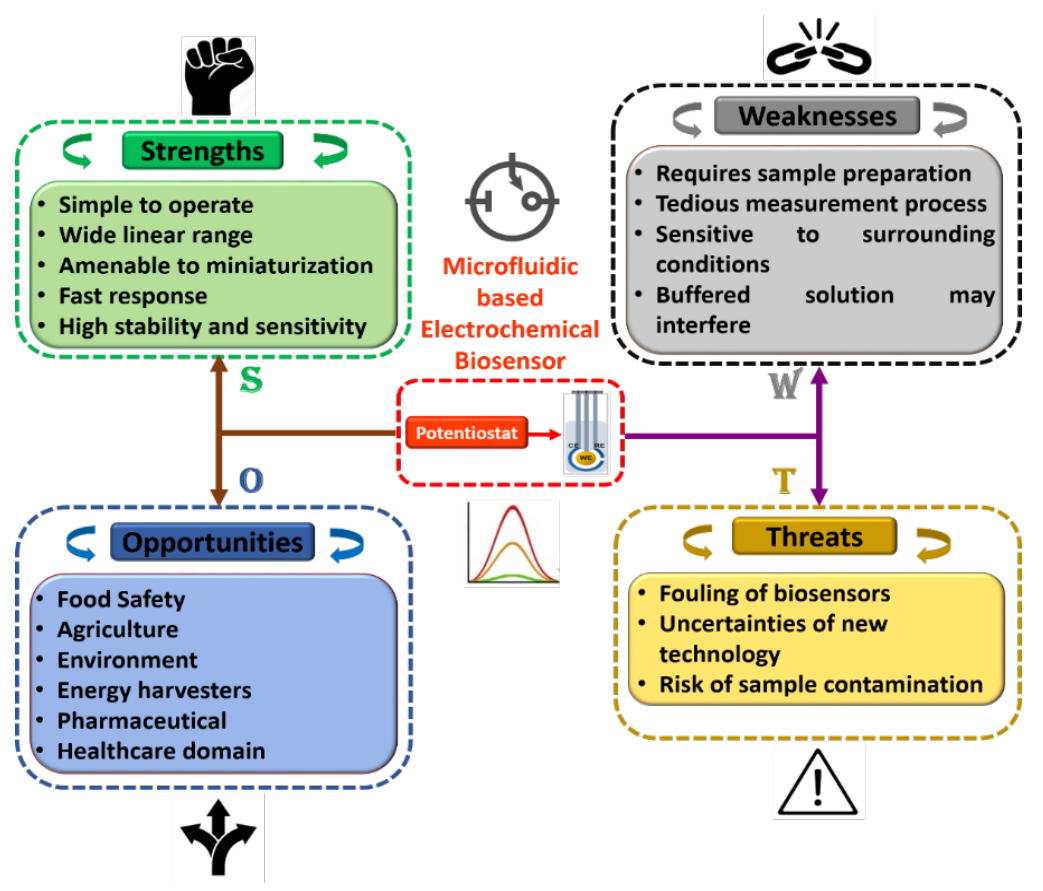
Figure 8. Detailed SWOT analysis of microfluidics-based electrochemical biosensors.